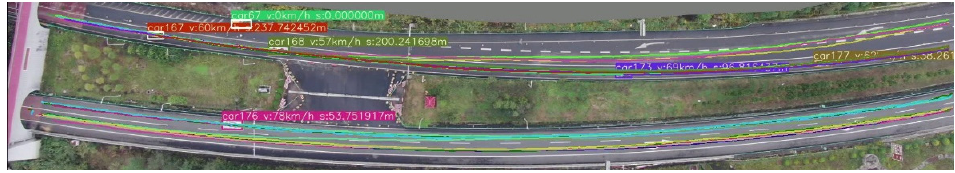
Figure 11. Continuous vehicle trajectory tracking.